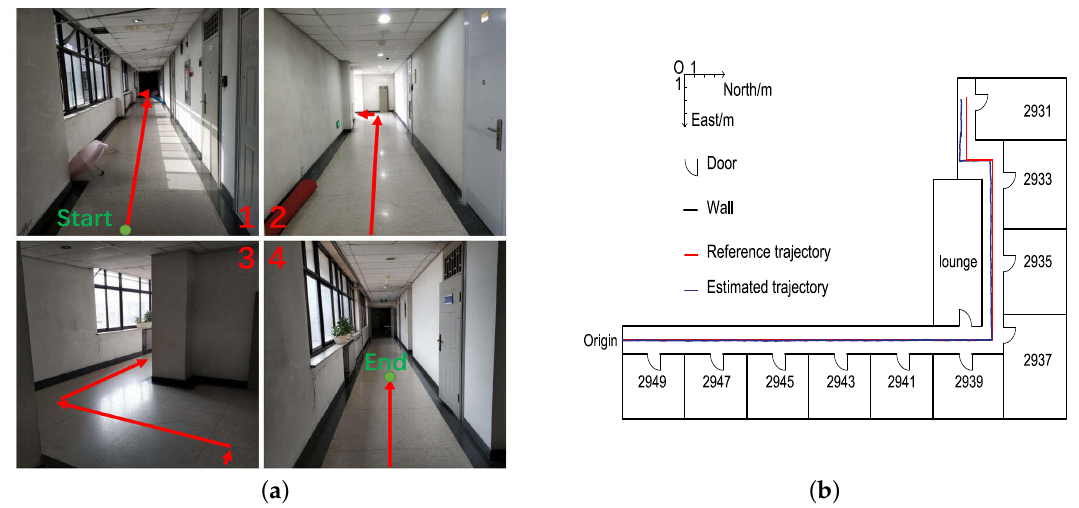
Figure 13. The performance of the ZUPT aiding INS. ( a ) Place where we walked; ( b ) the estimated trajectory.